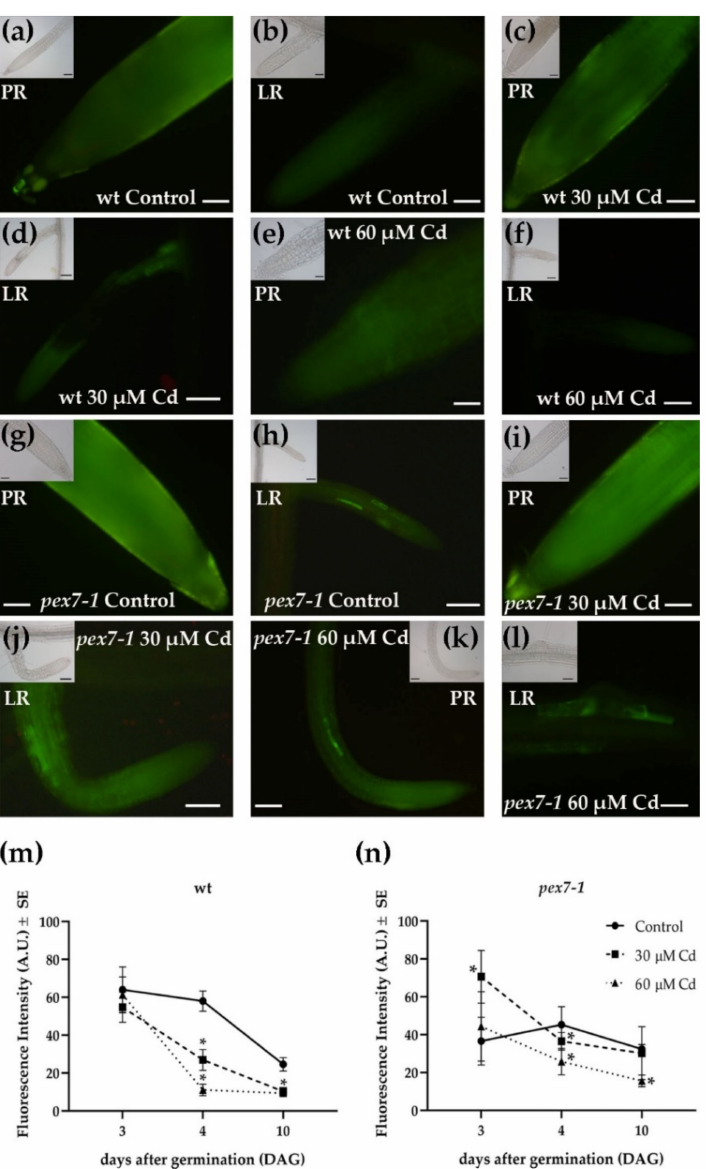
Figure 8. DCFH-DA epifluorescence analysis showing H 2 O 2 signal in the primary (PR) and lateral (LR) roots of wt ( a – f ) and pex7-1 seedlings ( g – l ) grown in the absence (( a , b , g , h ), Control) or in the presence of 30 µ M CdSO 4 (30 µ M Cd) ( c , d , i , j ) or 60 µ M CdSO 4 (60 µ M Cd) ( e , f , k , l ). Insets in ( a – l ) show the same field under white light. ( m , n ) Mean values ( ± SE) from three biological replicates of DCFH-DA fluorescence intensity at different days after germination (DAG) measured in the PR apices and elongation zones using ImageJ software (version 1.53c, Wayne Rasband, National Institutes of Health, Bethesda, USA) and expressed in arbitrary units (A.U.s; from 0 to 255). Asterisks show statistical differences for at least p < 0.05 level with respect to the Control within the same day. Bars = 100 µ m ( d , f , h , j , k ) and insets in ( a , d , f , h , j , k ), 50 µ m ( a – c , e , g , i , l ) insets in ( b , c , e , g , i , l ). n =